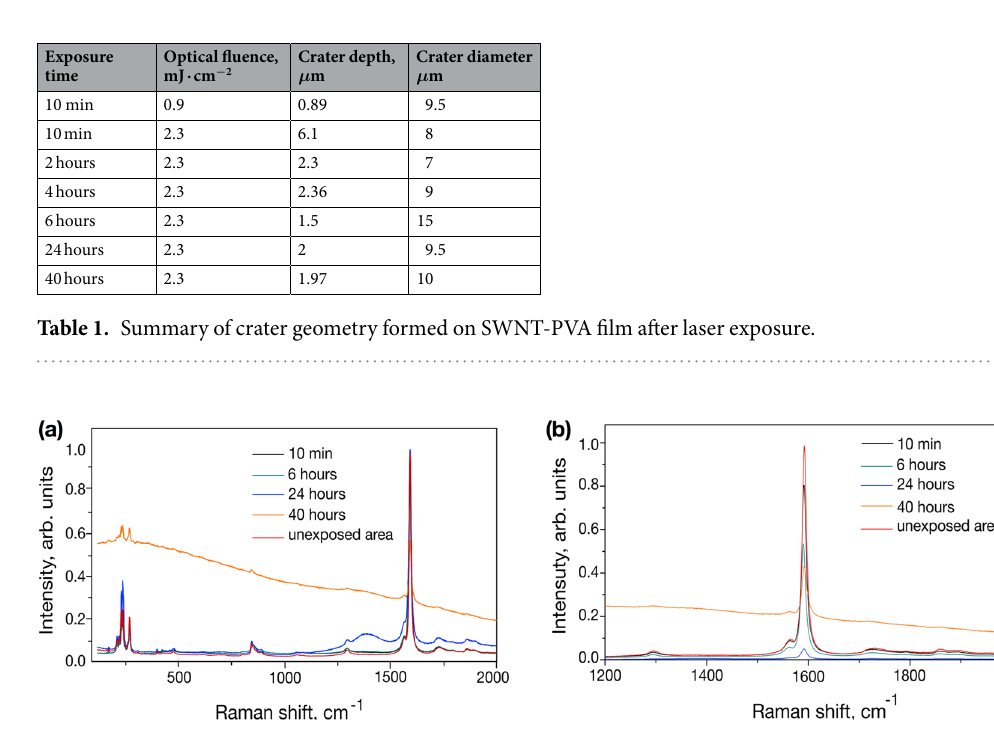
Figure 4. Raman spectra, collected from exposed and unaffected areas of SWNT-PVA films after 10 min continuous laser radiation exposure with an optical fluence of 0.9 mJ · cm − 2 , and 6 hours, 24 hours, and 40